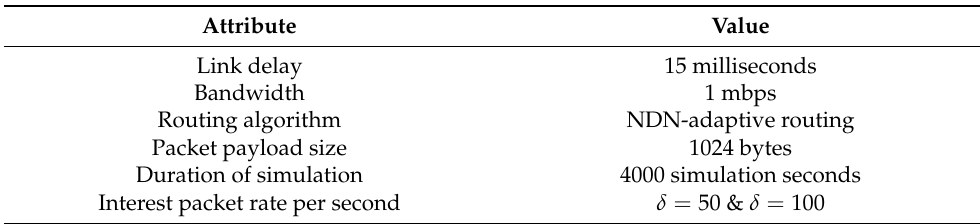
Table 5. Network simulation